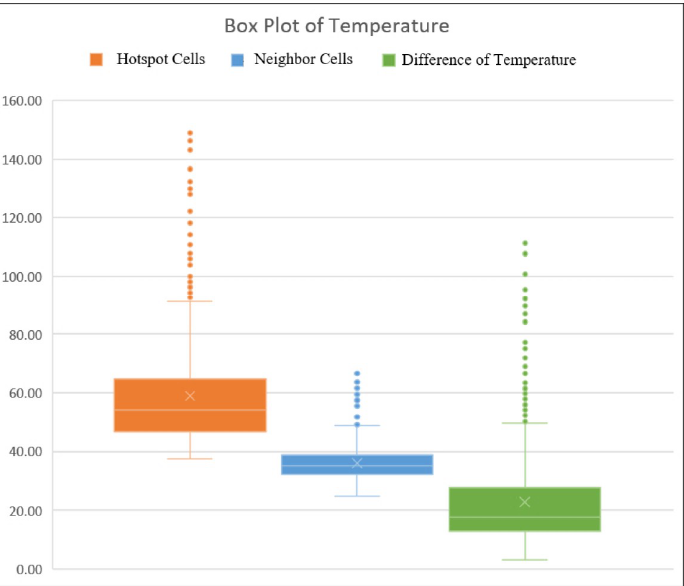
Figure 11. The boxplot of the temperature of hotspots, their neighboring cells, and differences between both. The bottom line of its box represents the first quartile, the medium line represents the second, and the top line the third. The outliers appear outside the maximum of its